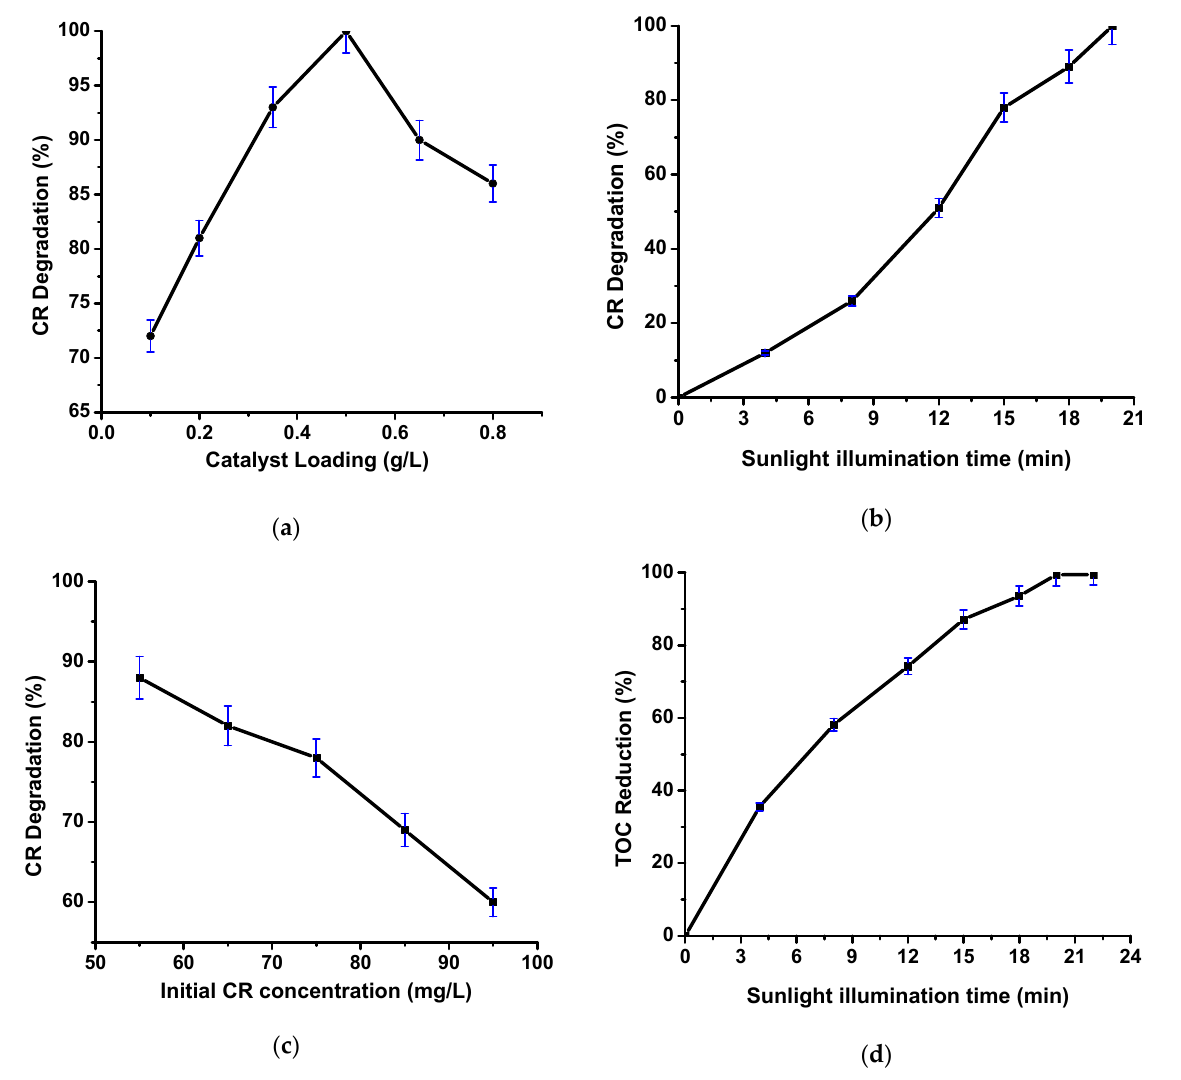
Figure 8. CR degradation efficiency with ( a ) Catalyst loading ( b ) Sunlight illumination time ( c ) Initial CR concentration and ( d ) TOC removal efficiency.